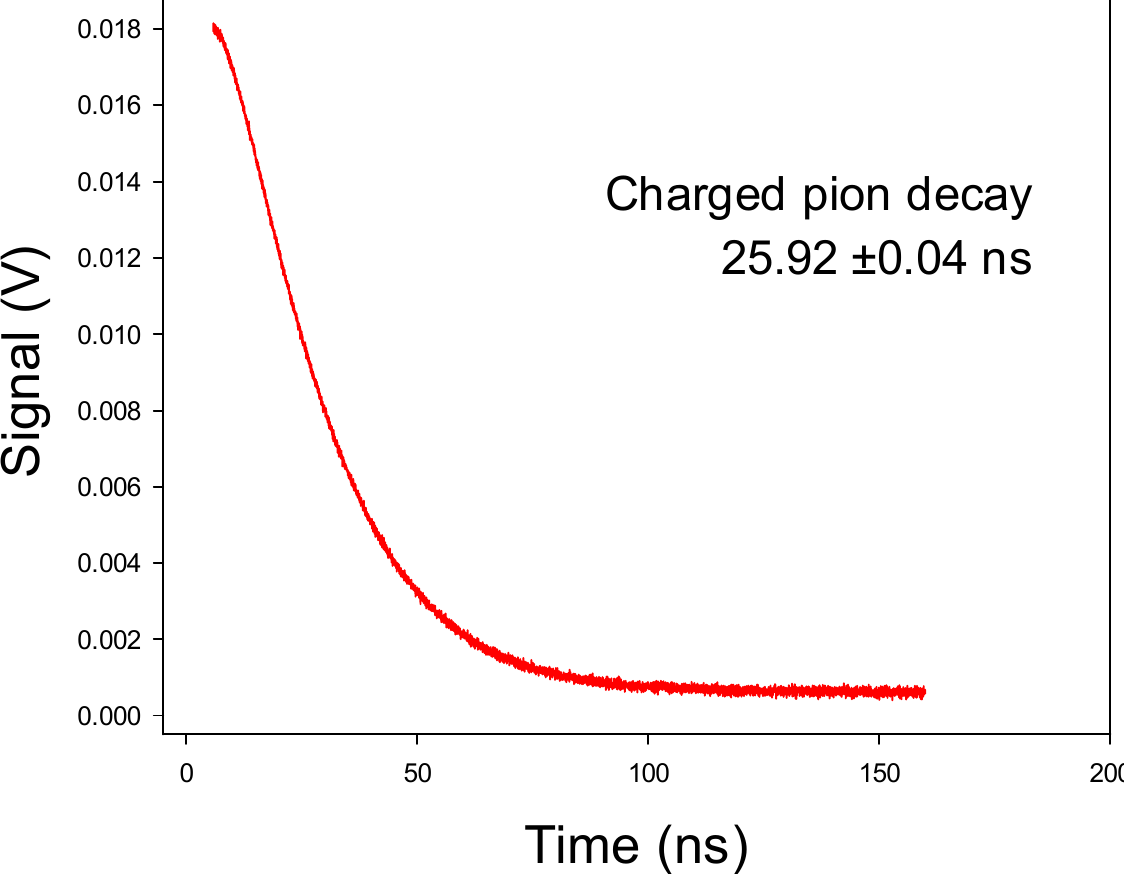
Figure 3. Decay of charged pions. D(0) on target, 50 mbar D 2 in chamber, partial charge separation with a pair of magnets, two foil collectors slightly offset on either side of the beam center with 50 V bias between them. Divider probes, difference signal between them shown. In this way, the signal from neutral kaons was suppressed.